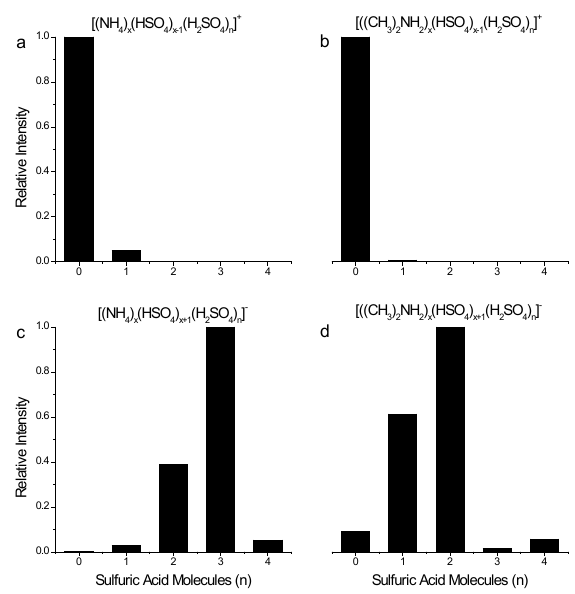
Fig. 2. Cluster acidity (defined as the number of unneutralized sul- furic acid molecules, n , in a cluster) for clusters formed through electrospray of ammonium sulfate and dimethylammonium sulfate solutions in positive and negative